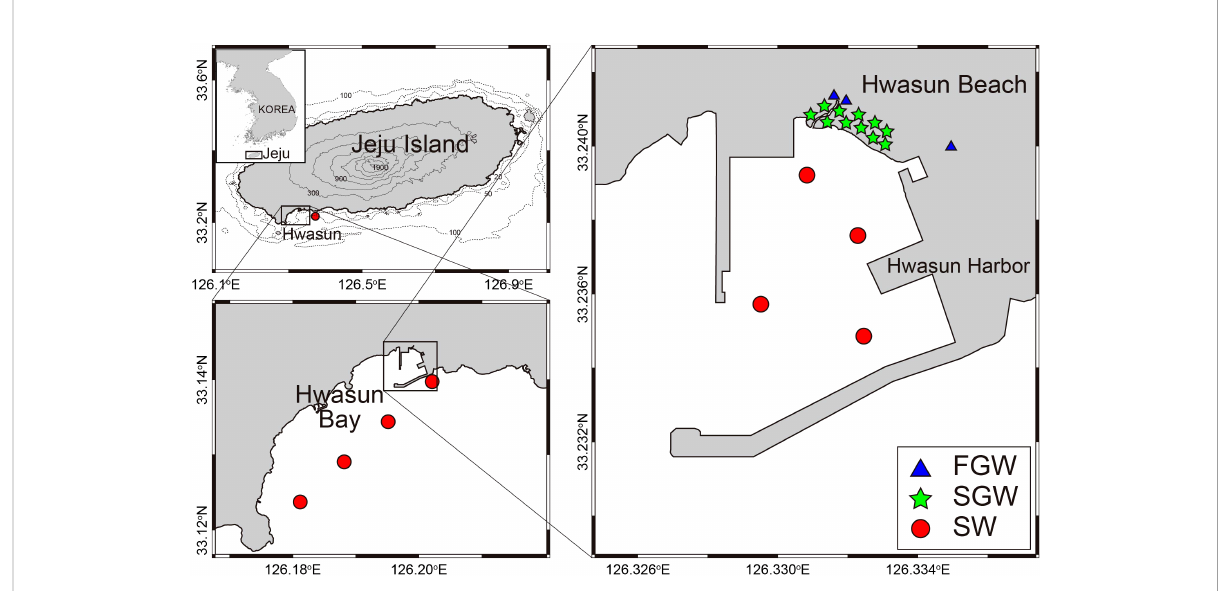
FIGURE 1 Maps showing study area and sampling stations for fresh groundwater (FGW), saline groundwater (SGW), and coastal seawater (SW). Modi fi ed from Kim et al.